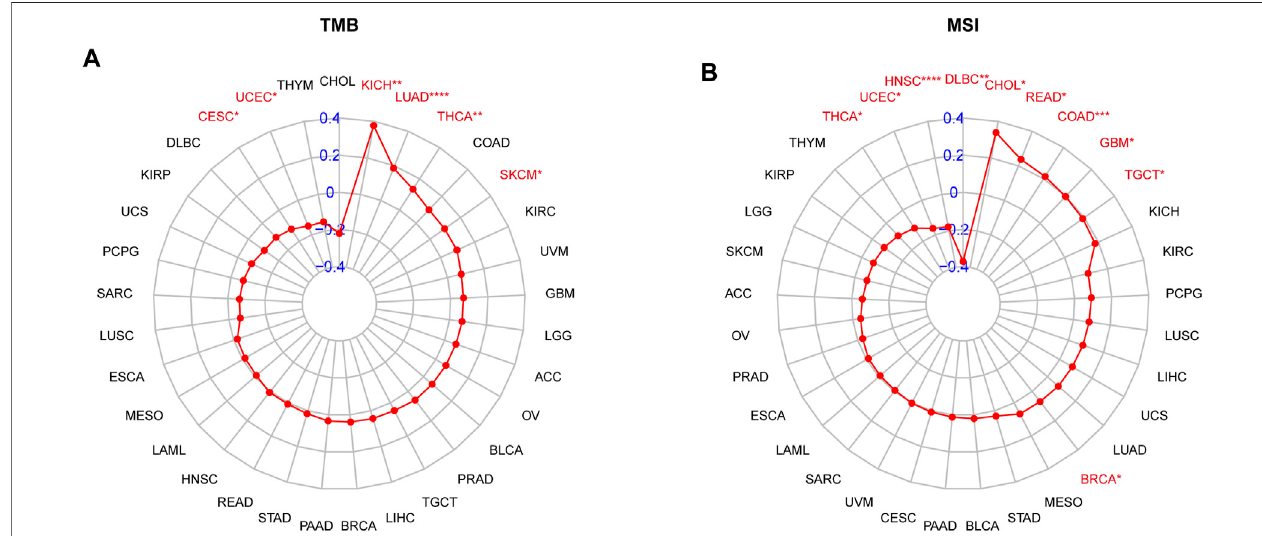
FIGURE 13 | The correlation between senescence score (SS) and immunotherapeutic markers. (A) Correlations of SS with TMB. (B) Correlations of SS with MSI. The red lines indicate correlation coef fi cients, and blue values indicate ranges. Red fonts indicate being statistically signi fi cant (Spearman correlation, p < 0.05 was considered signi fi cant, * p < 0.05, ** p < 0.01, *** p < 0.001, and **** p <